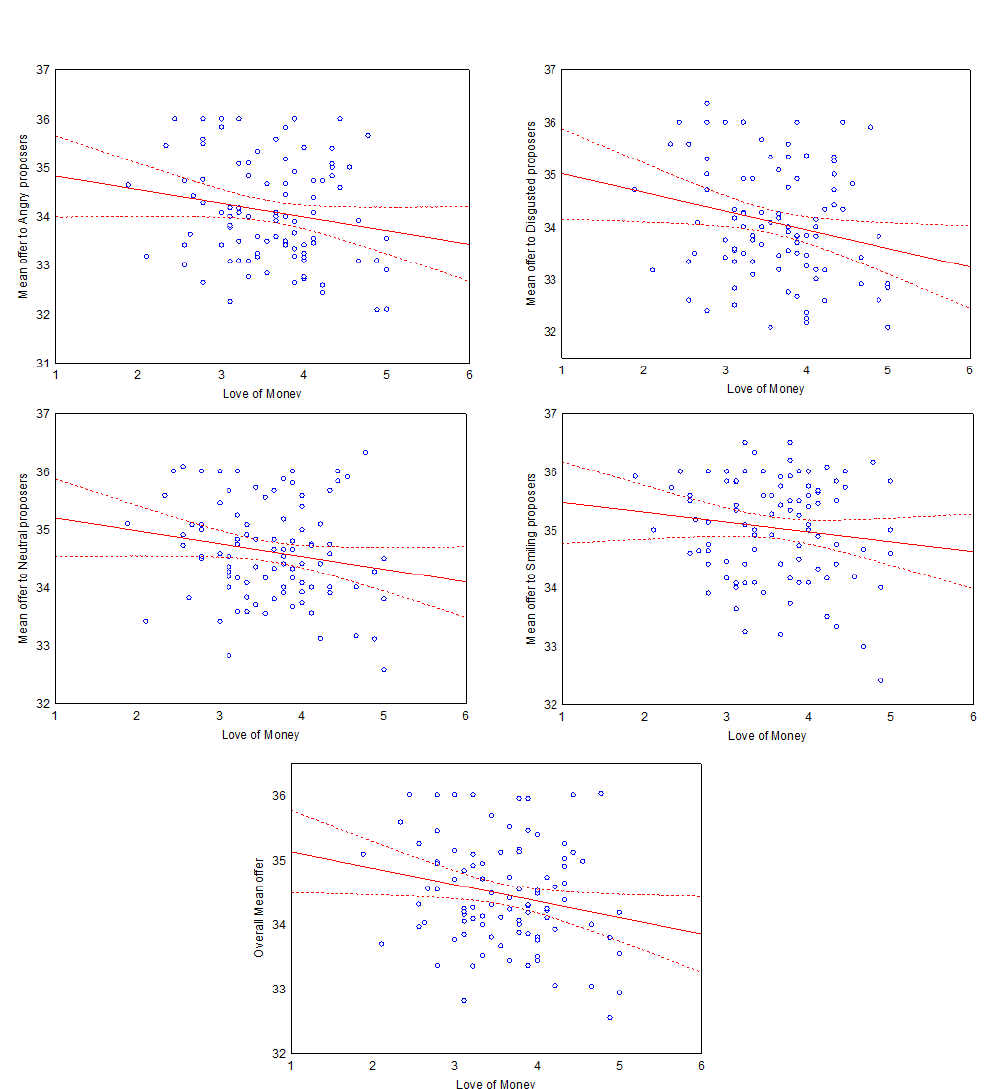
Figure 6. Correlation between Love of Money score and mean offer in different proposers’ emotional conditions. From top left : anger, disgust, neutrality, happiness and overall mean offer. Dashed lines denote 95% confidence interval. Table 4. Regression results: Age as a continuous predictor and angry, disgusted, neutral, happi- ness and overall average offer as DVs.